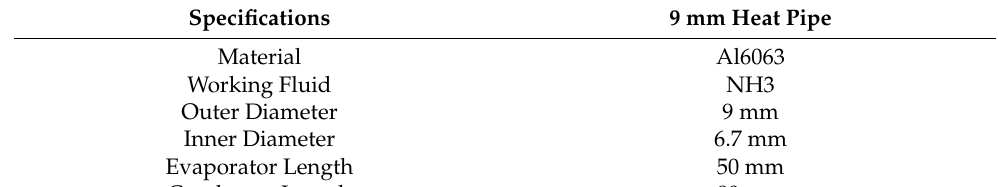
Table 1. Specifications of 9 mm heat pipe.